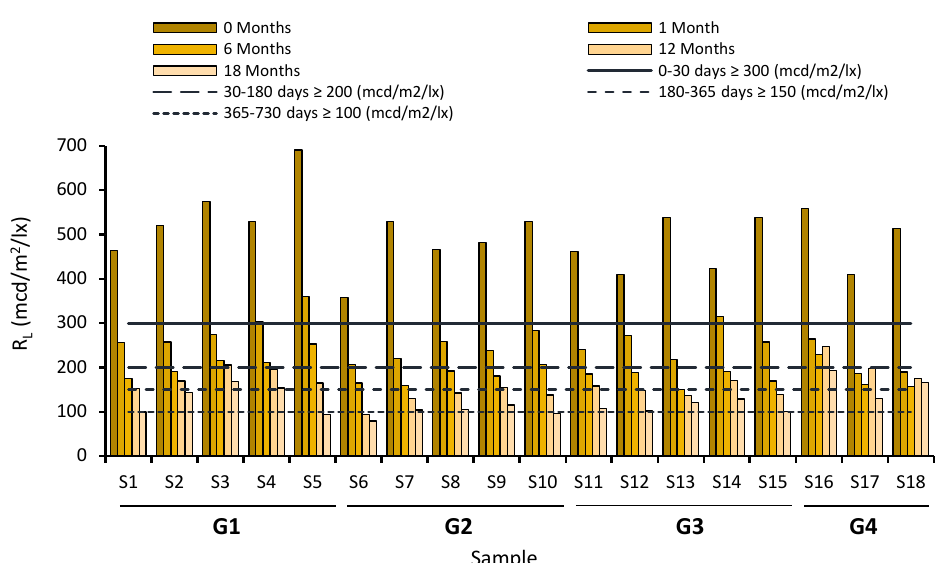
Figure 10. Evolution of R L on test samples during the first 18 months of service.